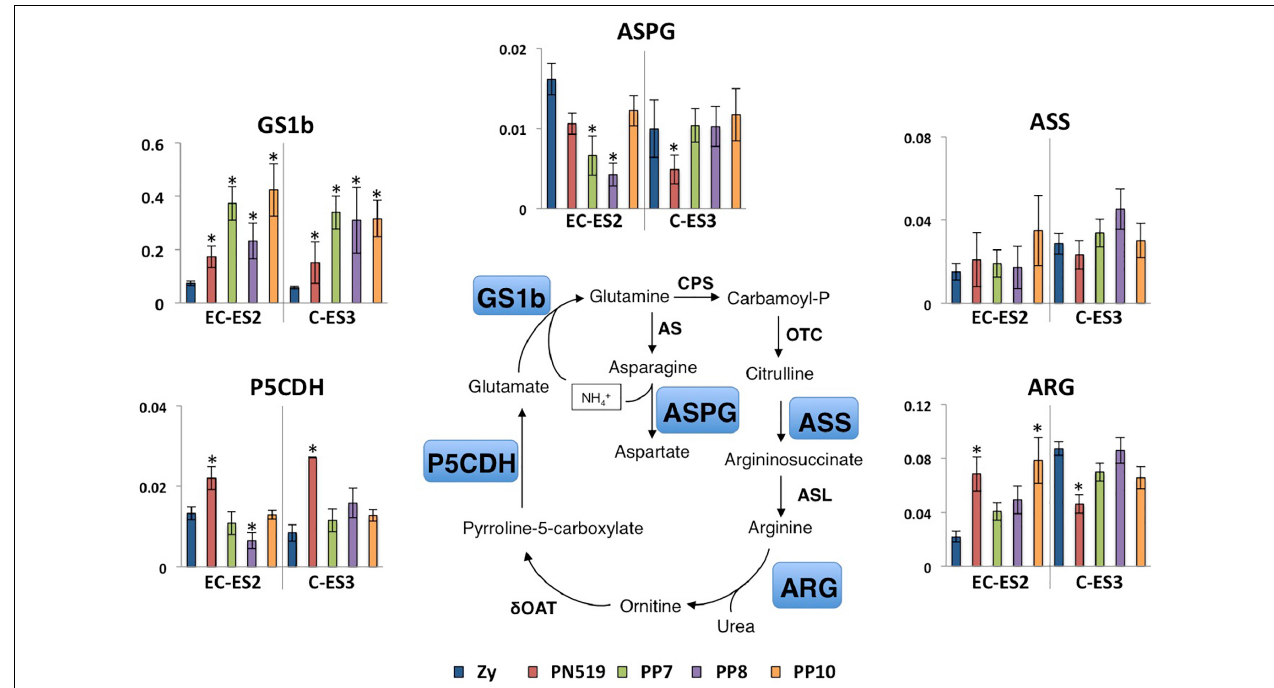
FIGURE 7 | Differential expression of genes involved in arginine metabolism. Quantitative analysis of transcript levels for genes that are differentially expressed in zygotic embryos (Zy) at early cotyledonary (EC) and cotyledonary stages (C) versus four somatic lines, PN519, PP7, PP8, and PP10, at pre-cotyledonary opaque (ES2) and cotyledonary (ES3) stages. Genes included in the analysis were those encoding glutamine synthetase (GS1b), asparaginase (ASPG), argininosuccinate synthase (ASS), arginase (ARG) and pyrroline-5-carboxylate dehydrogenase (P5CDH). Each value is the mean ± standard deviation of three biological replicates. Asterisks indicate significant differences between zygotic and somatic samples calculated using Student’s t -test ( P < 0.01). The expression level for all genes was normalized to that of Actin-7 as a reference gene.